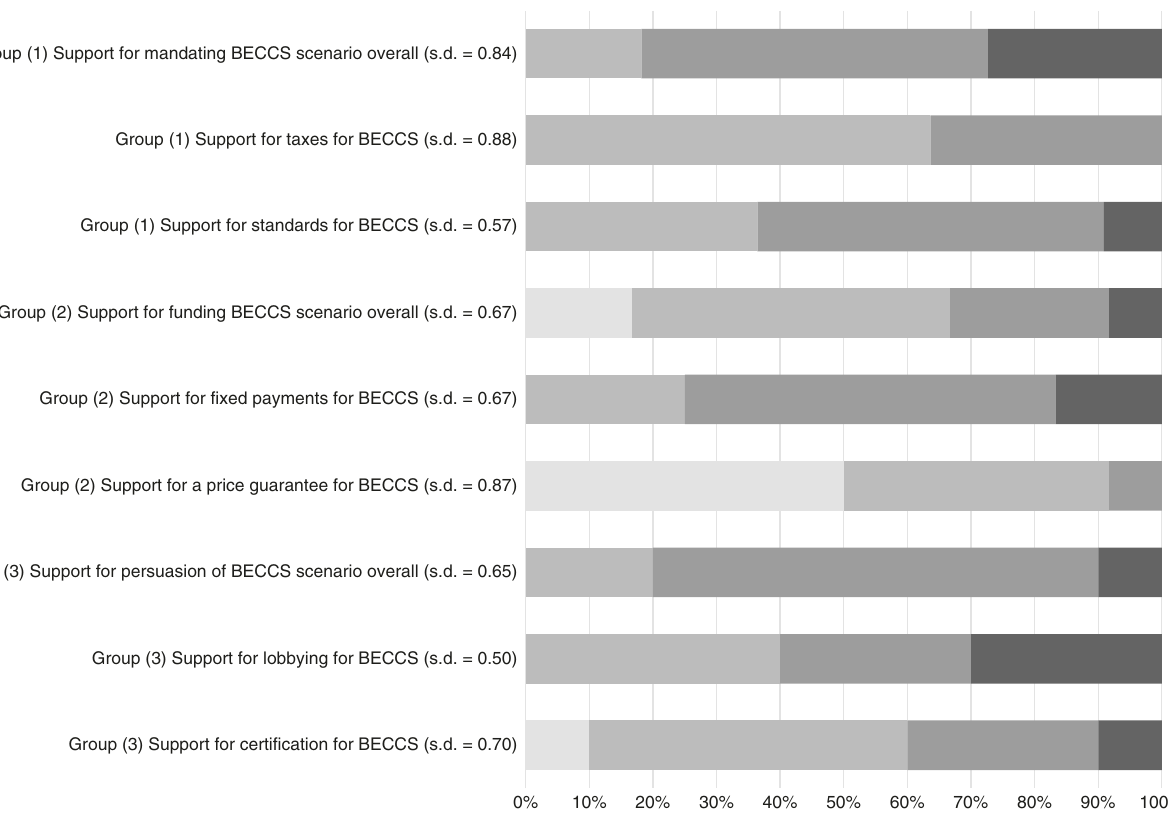
Fig. 2 Support for different policy scenarios and instruments for incentivising bioenergy with carbon capture and storage (% of participants, group 1 n = 11, group 2 n = 12, group 3 n = 10). Attitudes were elicited on a four-point scale (1 = strongly oppose, 2 = somewhat oppose, 3 = somewhat support, 4 = strongly support). The questions to which each dimension of BECCS pertains can be found in Supplementary Note